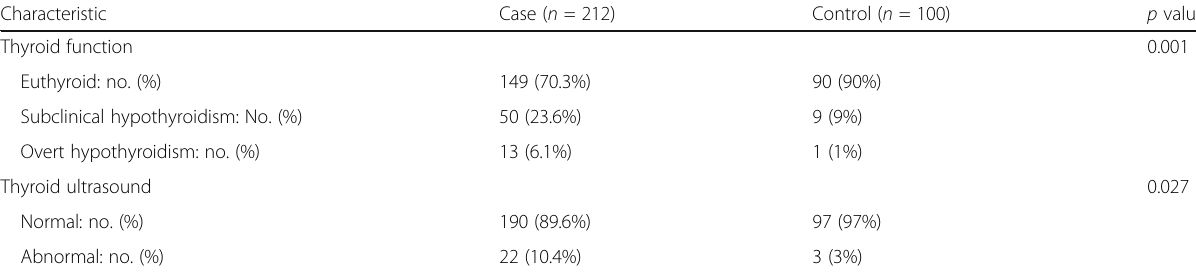
Table 2 Thyroid function and ultrasound between cases and control Characteristic Case ( n = 212) Thyroid function